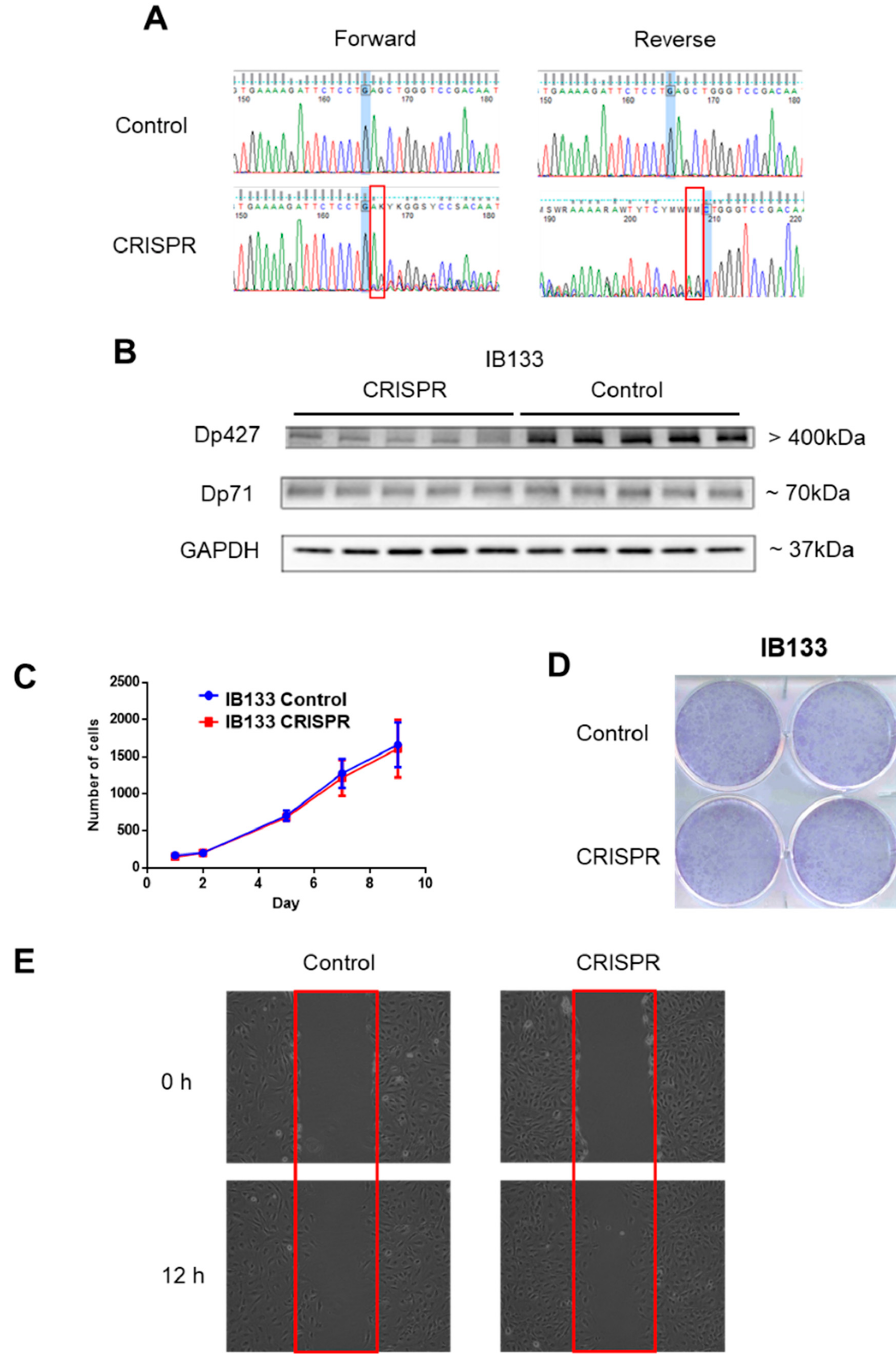
Figure 3. Dp427 downregulation had no impact on cell proliferation or clonogenicity. ( A ) Validation by Sanger sequencing of DMD deletions induced in IB133 cell line after lentiviral transduction of the CRISPR/Cas9 system. ( B ) Validation by Western blot of Dp427 downregulation in cell lines deleted by the CRISPR/Cas9 system. ( C ) Control (in blue) or deleted (at least partially) for Dp427 (in red) cell populations were cultured for 9 days and counted by flow cytometry, with six replicates for each time point. ( D ) Clonogenicity was measured with crystal violet staining and plates were scanned. ( E ) Cells were grown to confluence in six-well plates, and then a “scratch” (wound gap) was created in the cell monolayer using a pipette tip. Images were taken at the moment of the “scratch” (0 h) and 12 h later. Results shown are representative of three independent experiments performed in